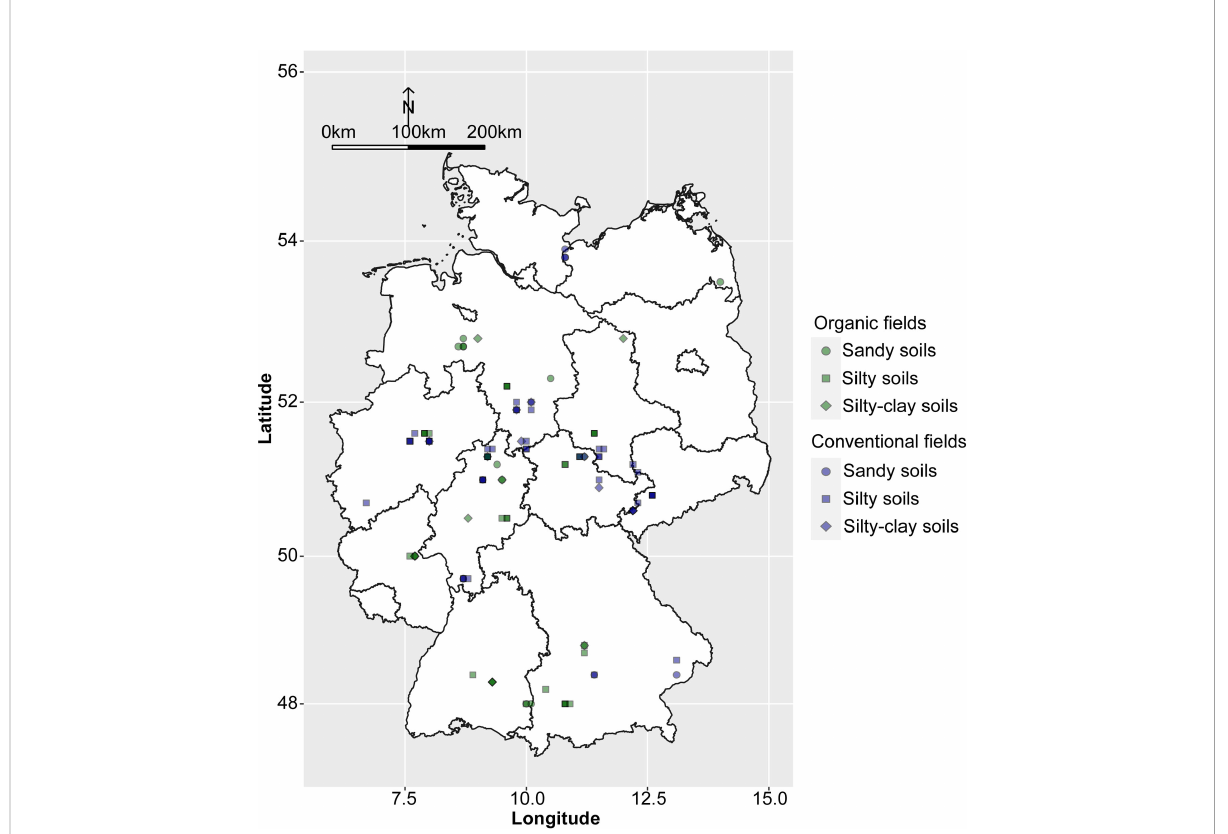
FIGURE 1 Map of Germany showing locations and the soil types of the surveyed organic and conventional faba bean fi